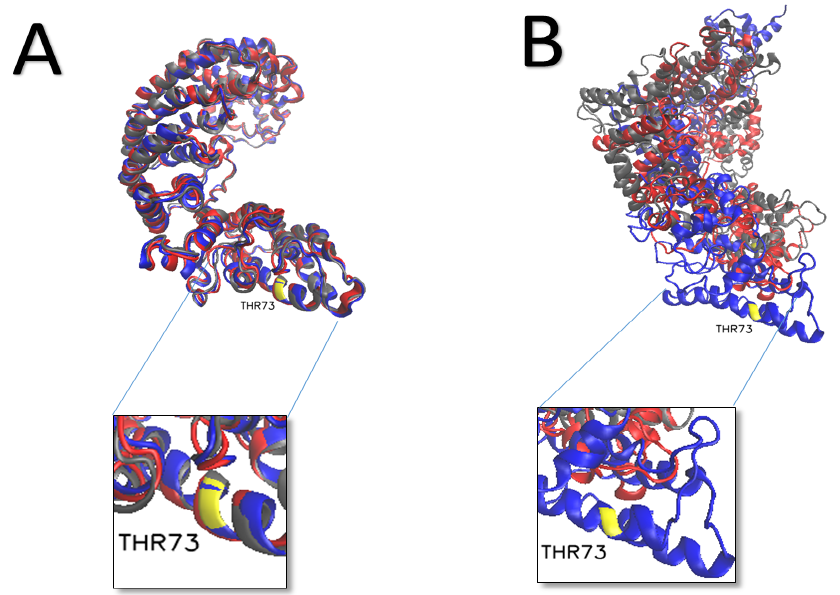
Figure 5. Changes in nsp2 structure with phosphorylation. The three simulated structures at time 100 ns (gray—WT, blue—T73, Red—S351). ( A ) at 0 nanoseconds; ( B ) after 100 nanoseconds.